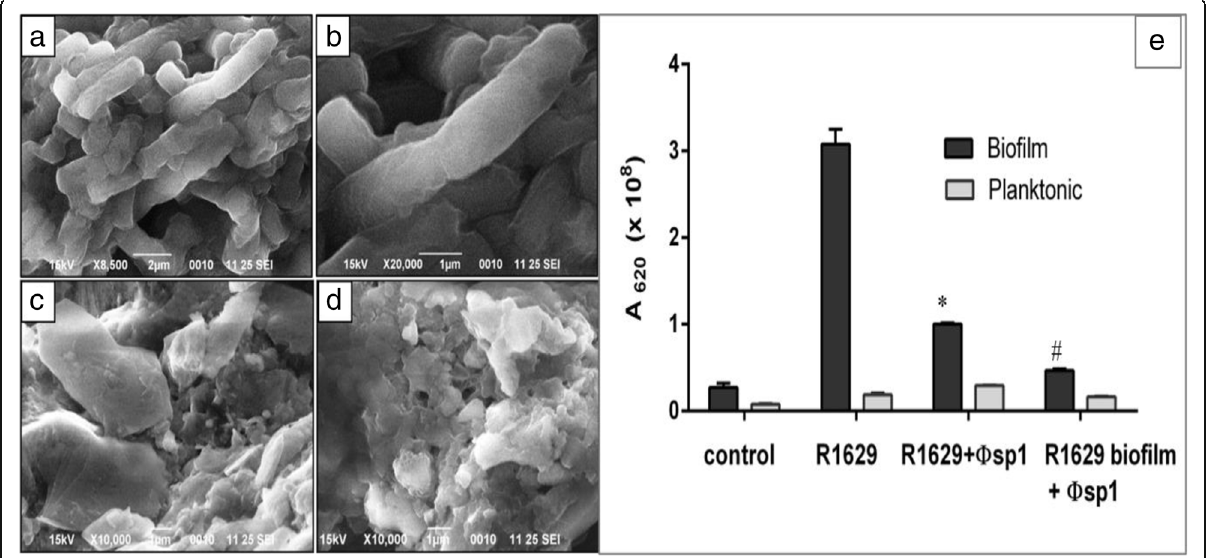
Fig. 3 SEM images of Ralstonia solanacearum strain 1629 biofilm. a Uninfected biofilm ×8500. b Uninfected biofilm at ×20,000. c Biofilm treated with phage ɸ sp1 (1 MOI) at ×10,000 showing disrupted cells. d Biofilm treated with phage ɸ sp1 (10 MOI) at ×10,000 showing cell debris. e Phage ɸ sp1 biocontrol of biofilm formation and eradication of R. solanacearum strain 1629 (R1629). * p ≤ 0.0073 (for biofilm formation), # p ≤ 0.0017 (for